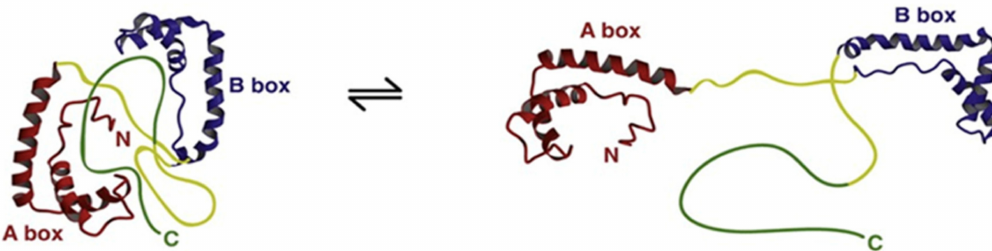
Figure 2. Schematic representations of a hypothetical compact, “tail-bound” form of HMGB1 in equilibrium with a more open form of the protein as deduced from dynamic structural analyses. The different domains of HMGB1 are indicated